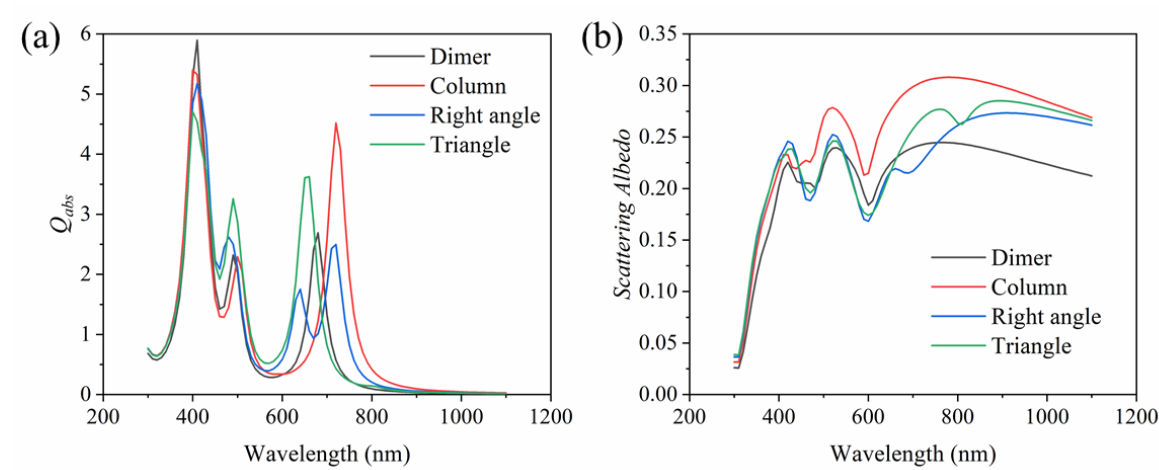
Figure 10. Comparison of ( a ) absorption efficiency and ( b ) scattering albedo of plasma dimer and three Ag plasma trimers with special structures.